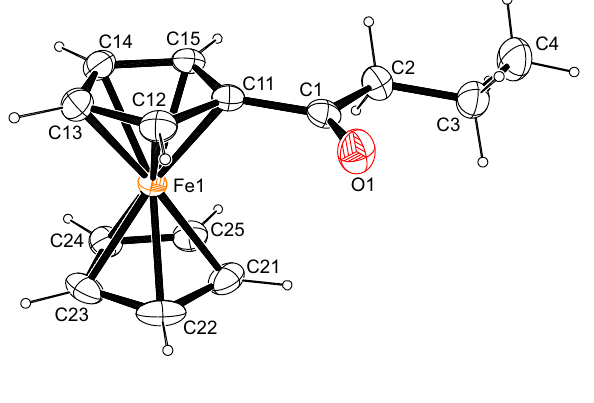
Table  : Data collection and